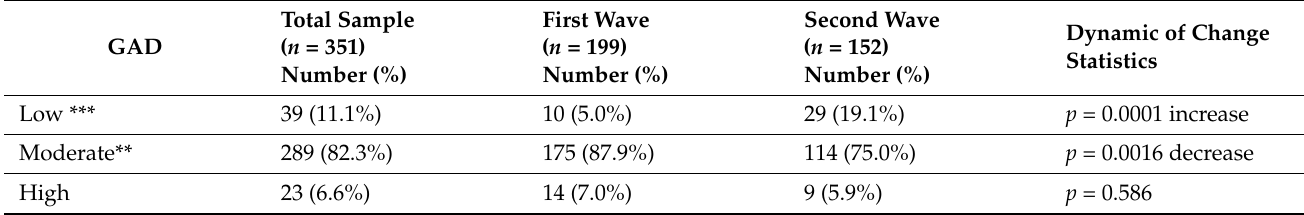
Table 6. Specific PSS-10 scoring